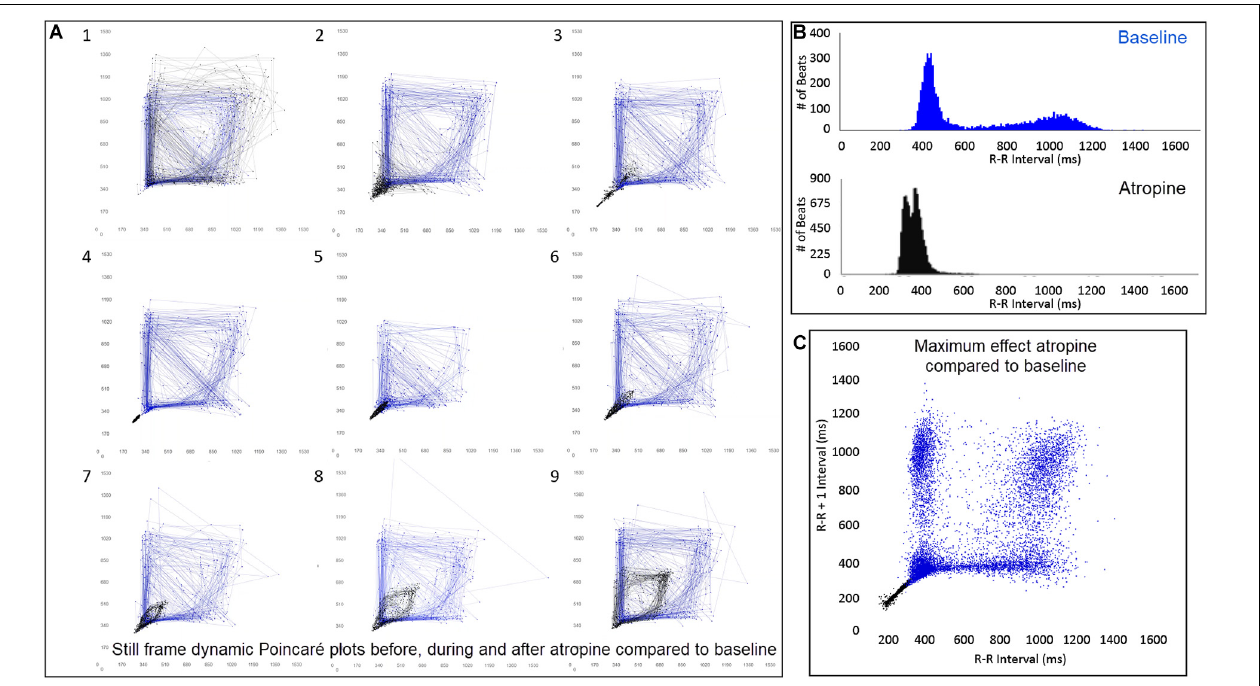
FIGURE 12 | ( Supplementary Video 8 ) Still frames from dynamic Poincaré plots (Frame A1–9 ) from the electrocardiographic recordings from two different days during a stable rest period (blue) and just before, during and after administration of atropine (black) (0.04 mg/kg given intravenously) in beagle 8. Dots represent the beat-to-beat interval (R–R interval surrogate for P–P interval with all these verified to be sinus in origin) with lines connecting the next beat-to-beat interval. Each frame shows 500 beat-to-beat intervals. After atropine, the parasympatholytic effects result in the beat-to-beat intervals becoming shorter (Frames 1–4 ) and as parasympathetic modulation returns, the beat-to-beat intervals become longer (Frames 5–9 ). Note that after treatment with atropine the beat-to-beat patterning characterized by a bifurcation collapses to short intervals that hug the line of identity. When the heart rate slows (longer beat-to-beat intervals) with the decreasing drug effect, the bifurcation is identified again. In frame (B) , the number of beats at a particular beat interval are shown for the stable rest time (blue) and during treatment with atropine (black). The double peak during the atropine treatment represents the faster rate during the intravenous injection followed by the true drug effect and its short beat-to-beat intervals. In frame (C) , the Poincaré plot illustrates a comparison without the connecting lines of the entire baseline period and the time of maximum effect of atropine. Supplementary Video 8 complements this